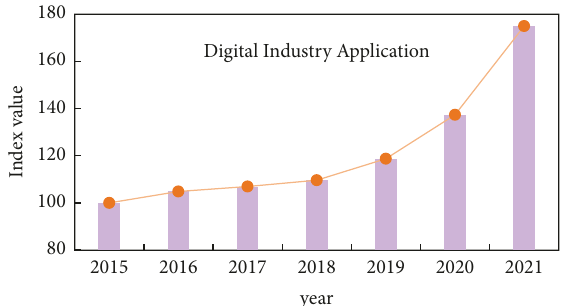
Figure 8: Digital industry application evaluation